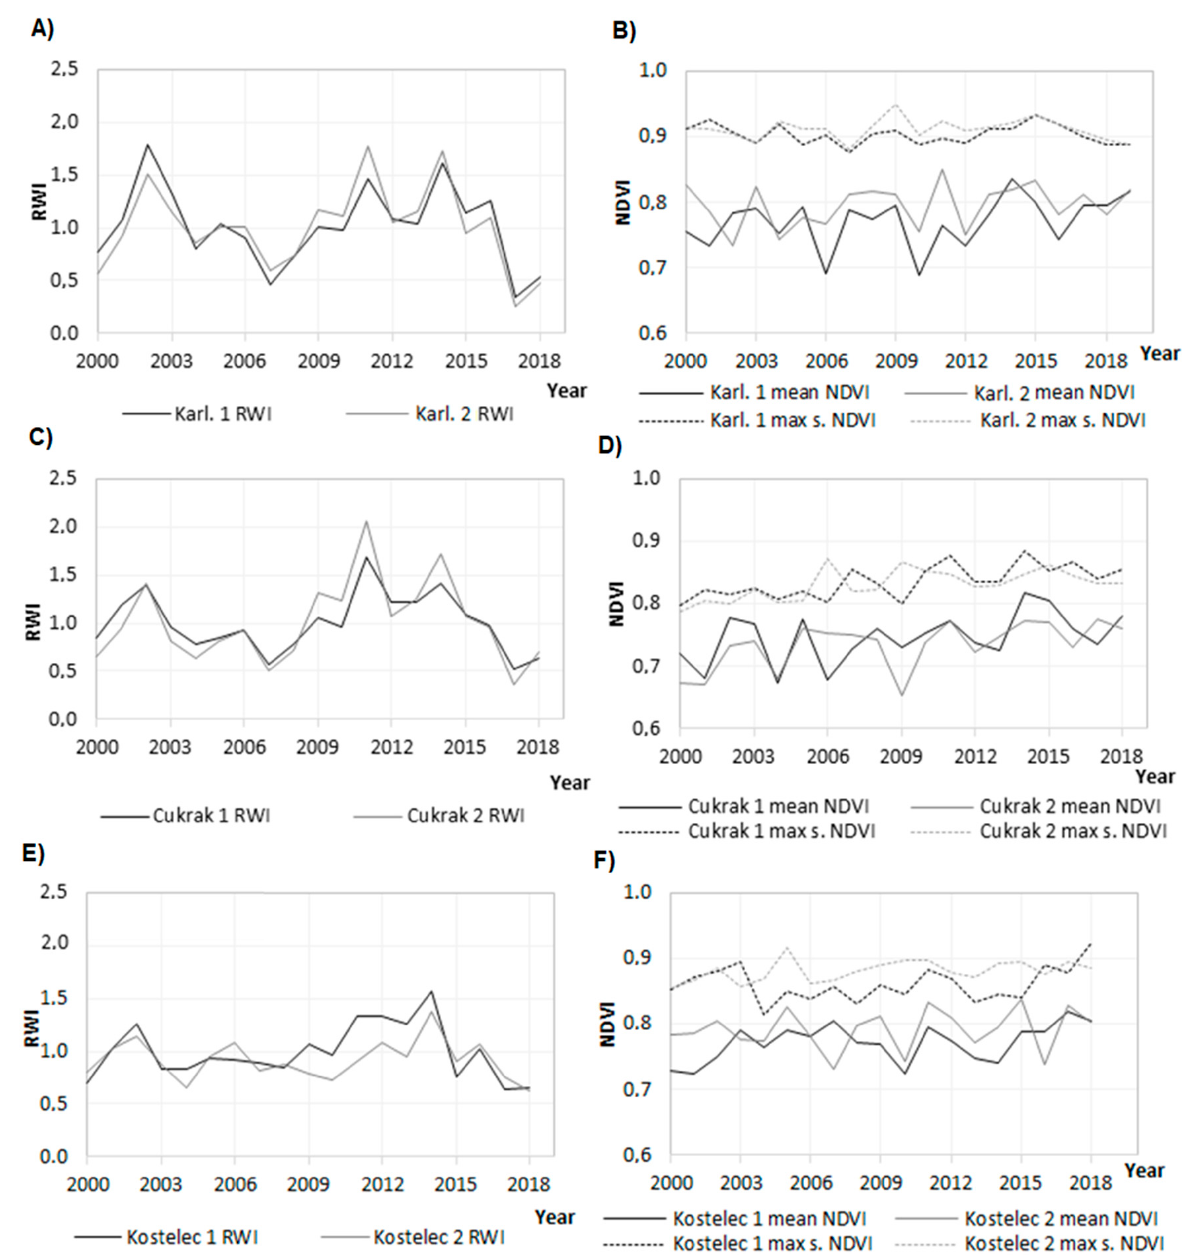
Figure 4. Description of tree-ring width index (RWI) and normalized difference vegetation index (NDVI) for the period 2000–2018. ( A ): RWI for 2000–2018, Karlstejn 1 and 2; ( B ): mean and maximum NDVI values for 2000–2018, Karlstejn 1 and 2. ( C ): RWI for 2000–2018, Cukrak 1 and 2; ( D ): mean and maximum NDVI values for 2000–2018, Cukrak 1 and 2. ( E ): RWI for 2000–2018, Kostelec 1 and 2; ( F ): mean and maximum NDVI values for 2000–2018, Kostelec 1 and 2. Notes: Karl.—Karlstejn,